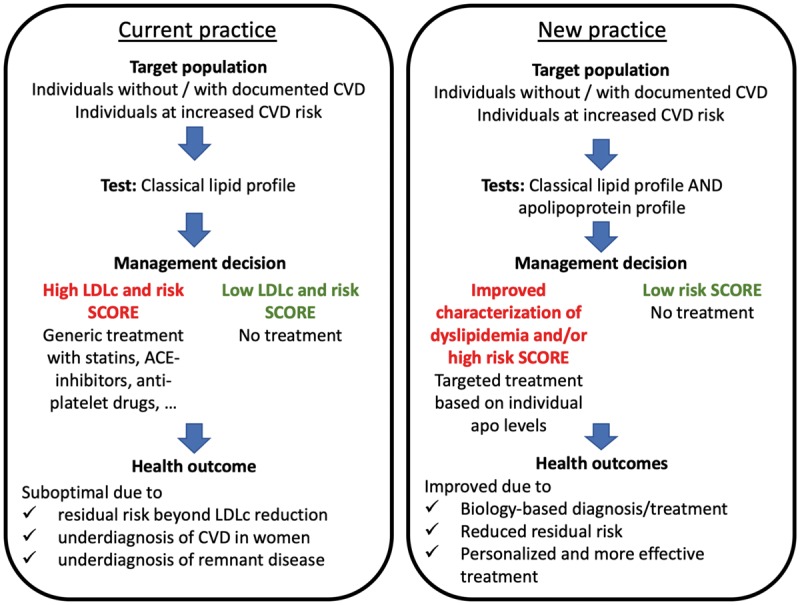
Clinical test-treatment pathways for CVD reduction according to current and new practices.Source: reproduced with permission from Elsevier.7